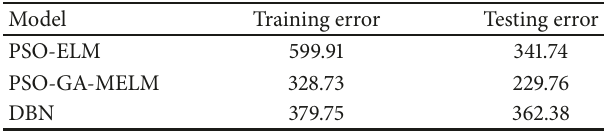
Table 3: The prediction error for the algorithms PSO-ELM, PSO- GA-MELM and